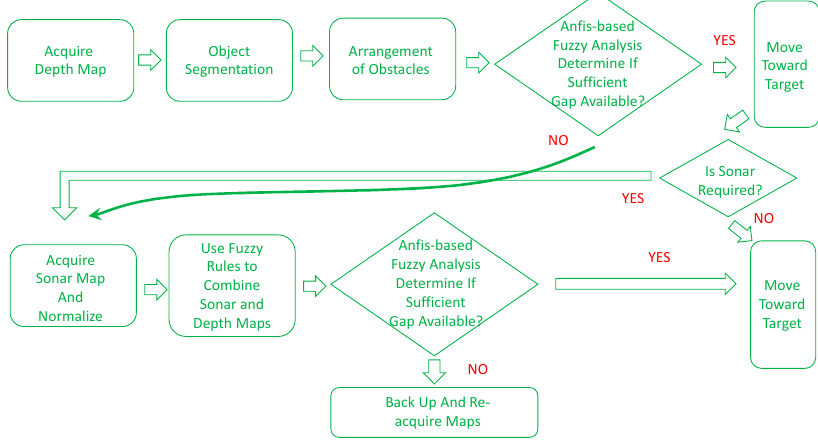
Figure 7. The flowchart for robot’s obstacle avoidance.